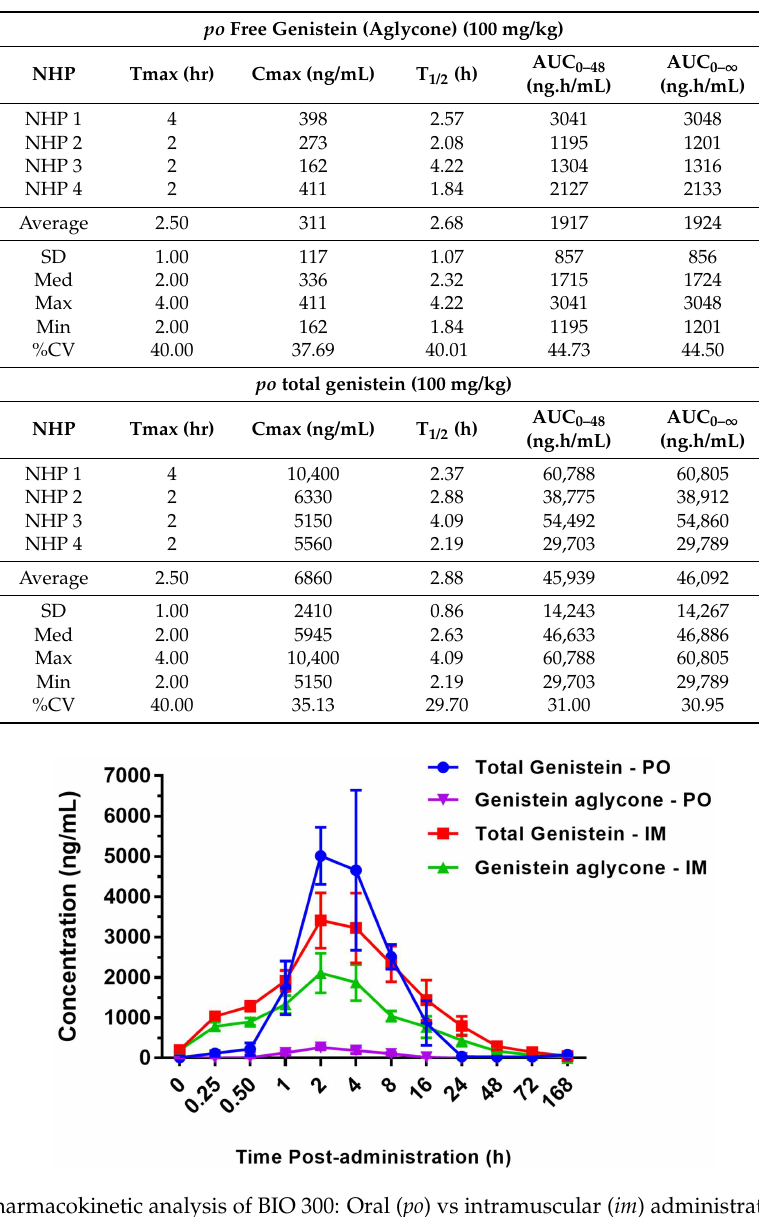
Table 2. PK po study sample analysis of free and total genistein.